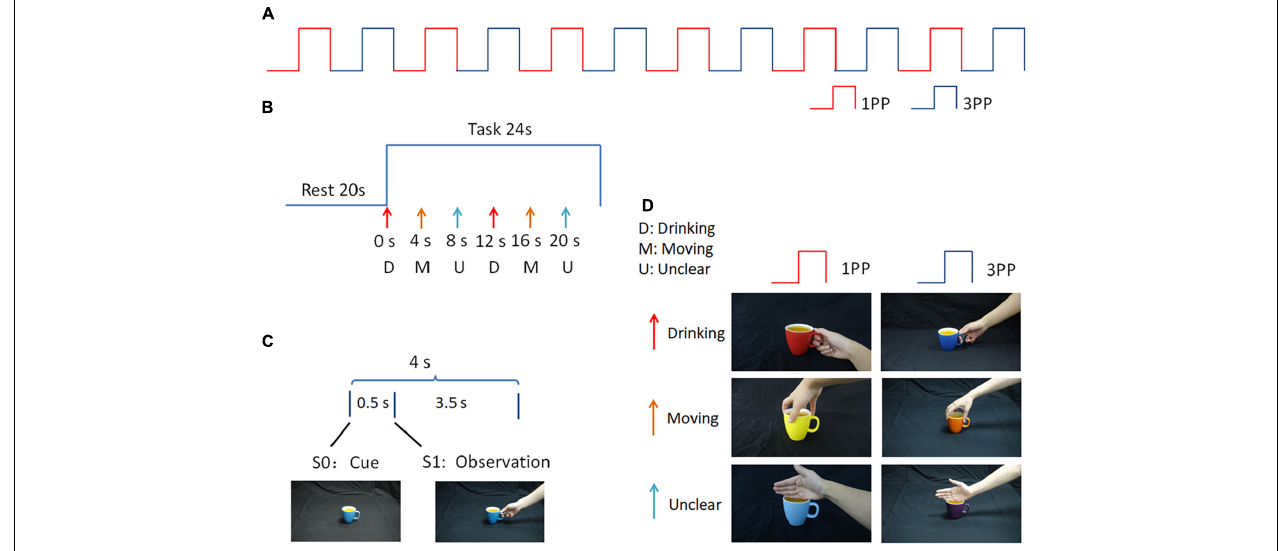
FIGURE 1 | Experimental paradigm. (A) 1PP and 3PP stimuli were presented alternately for six blocks; (B) Each block consists of rest and task periods. During the task period there were six trials, in which D, M, and U stimuli were displayed sequentially and repeated twice, in different colors; (C) Each trial consisted of a hand-cup interaction stimulus presented after a cup-only cue; (D) Examples of the stimuli used in this